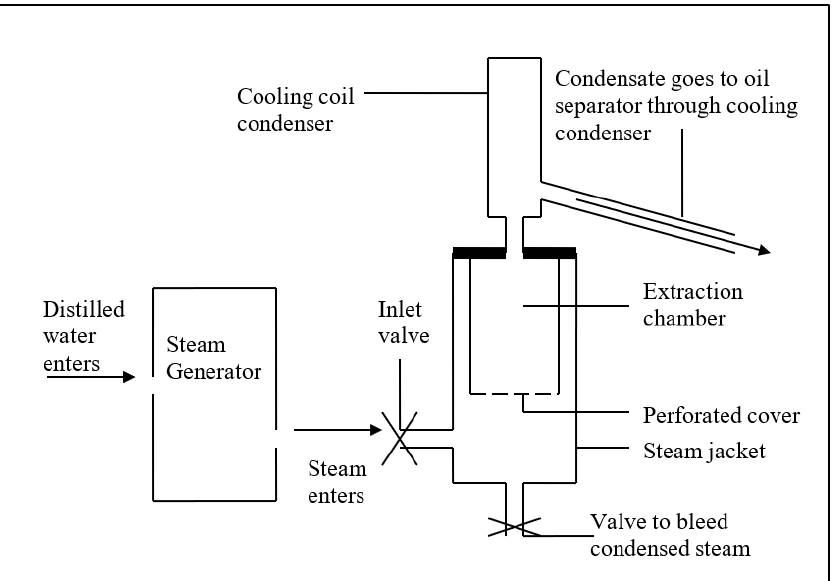
Figure 1. A schematic flow chart of the Steam Distillation Extraction (SDE) pilot plant apparatus.